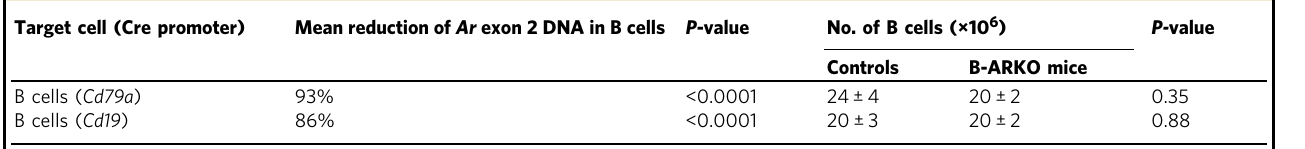
Table 1 AR regulation of splenic B cells is not B cell-intrinsic Target cell (Cre